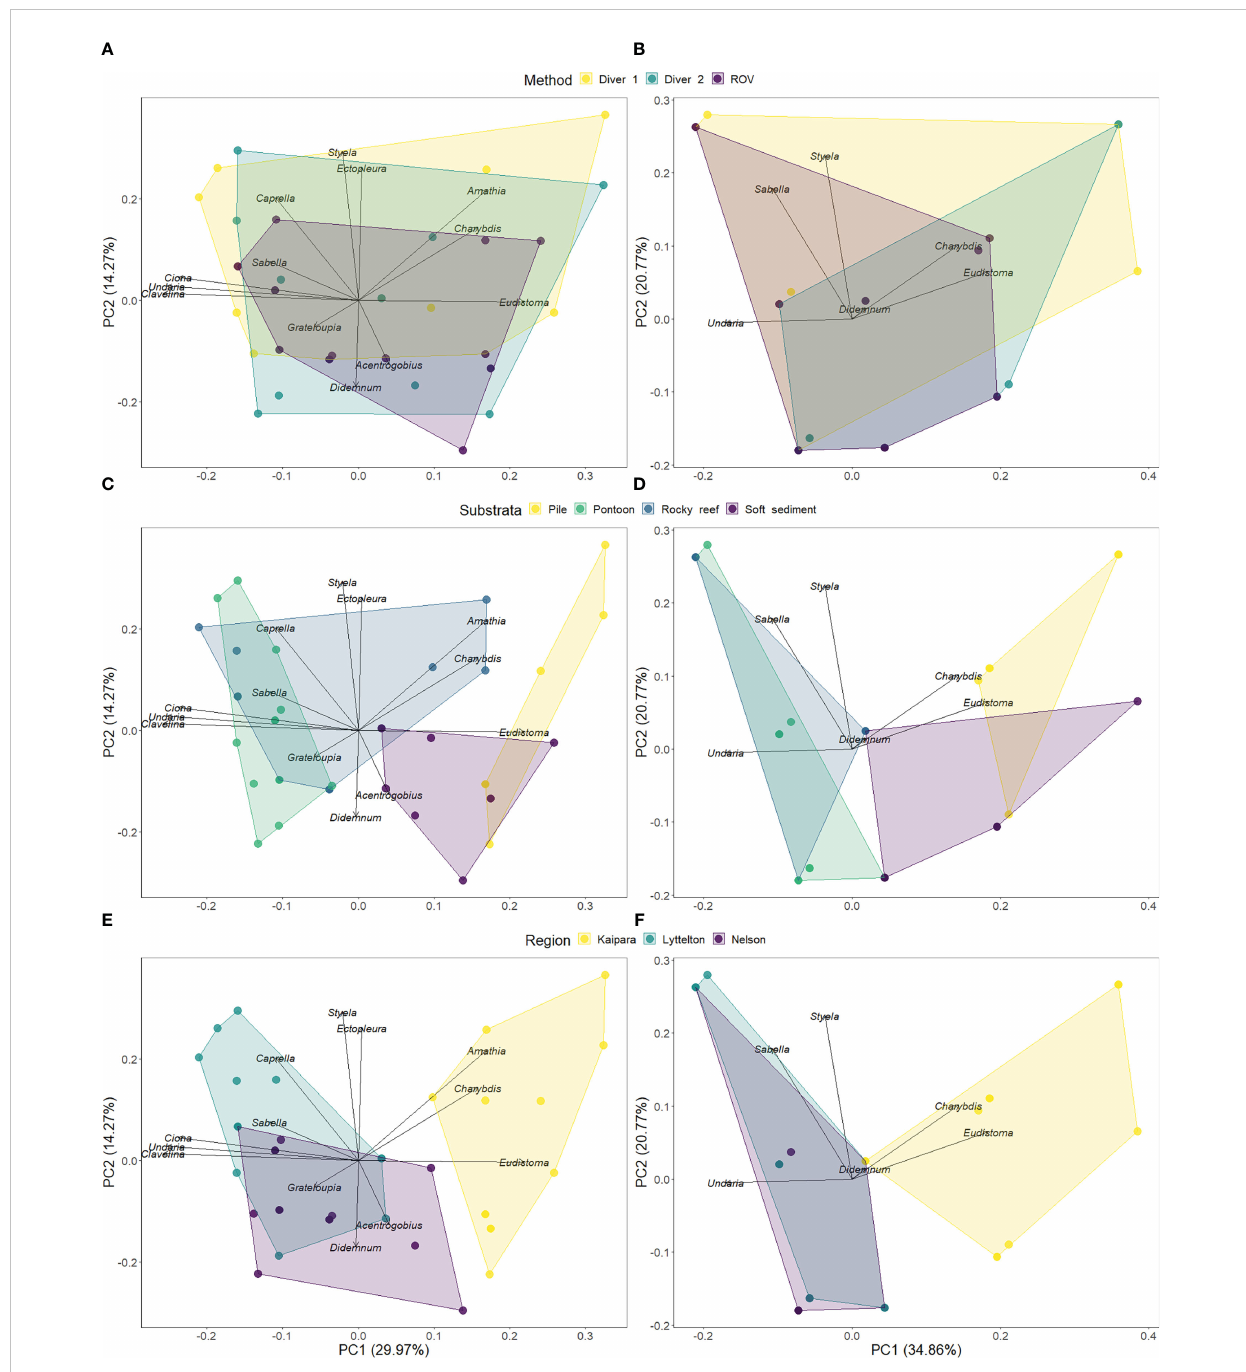
FIGURE 5 NIS assemblage composition detected at each replicate study site for each method (identi fi ed as coloured dots) as visualised in two-dimensional space. The spread of the points re fl ects the difference in the composition of species found at each site, with the contribution of each species to this spread indicated by the radiating vectors. The coloured polygons show the spread of detections encompassed within different factors (e.g., methods (A, B) , habitats (C, D) , and regions (E, F) . Highly overlapping polygons reveal similar detection of species pro fi les, while non-overlapping polygons show unique species pro fi les. Principal Coordinate Analysis (PCA) plots are generated for the total NIS assemblage (A, D, E) , and for a subset of the “ targeted species ” (B, D, F) . For the total assemblage and the subset, each panel retains the same data, but changes in the presentation of the factors (i.e., method, habitat and region) to visualise overlap and separation of the NIS assemblages